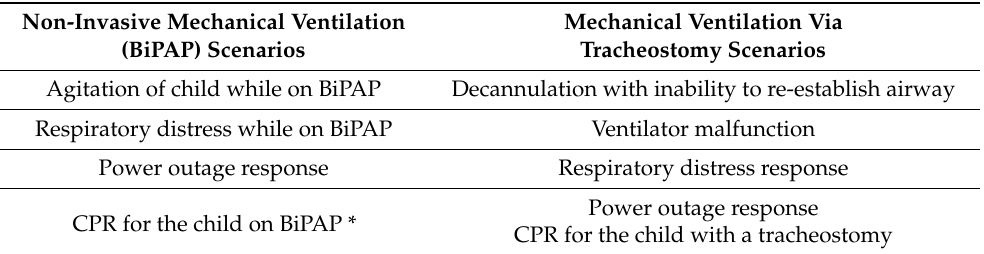
Table 2. Emergency scenarios for BiPAP and mechanical ventilation via a tracheostomy.